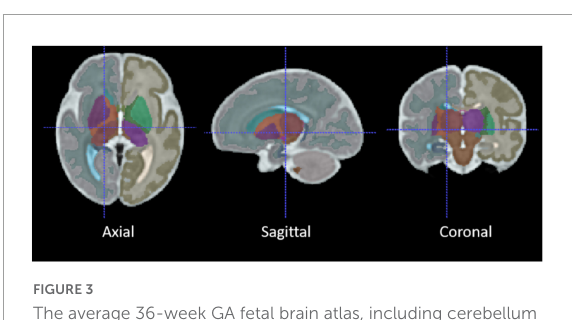
FIGURE3 The average 36-week GA fetal brain atlas, including cerebellum and thalamus labels. The axial, sagittal, coronal, and 3D rendered views of the age-appropriate fetal brain atlas whereby deep brain tissues are color-coded.